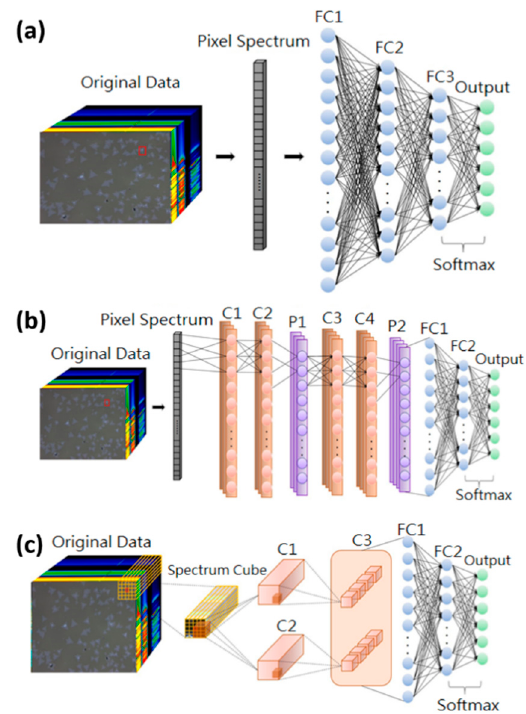
Figure 2. Schematic of the model construction. ( a ) Deep neural network (DNN), ( b ) one-dimensional (1D) convolutional neural network (1D-CNN), and ( c ) three-dimensional (3D) convolutional neural network (3D-CNN), where the inputs in ( a , b ) are hyperspectral vectors, and the input in ( c ) is hyperspectral cube. For the outputs of the three models, Softmax is used as a classifier for six categories: substrate, monolayer, bilayer, trilayer, bulk, and residues.